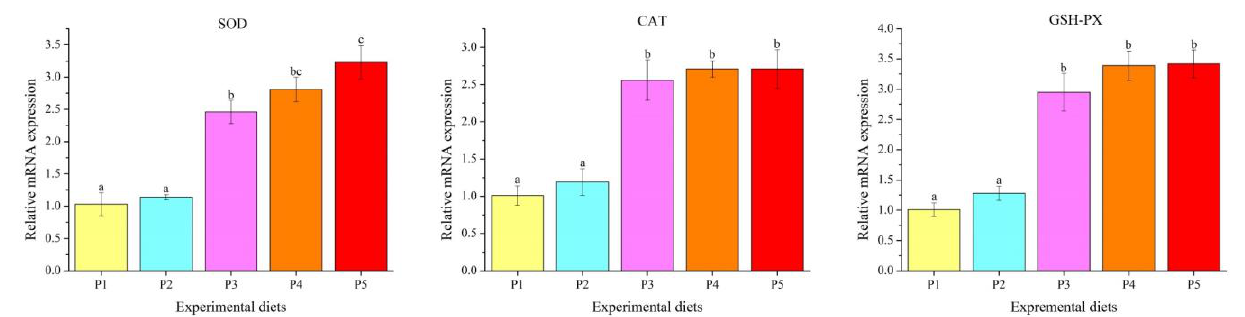
Figure 4. The mRNA levels of antioxidant-related genes in the liver of Oncorhynchus mykiss fed experimental diets. Values are presented as mean ± SE, n = 4. Means with different superscripts are significantly different ( p < 0.05). SOD: ANOVA, 0.000; linear, 0.000; quadratic, 0.000. CAT: ANOVA, 0.000; linear, 0.000; quadratic, 0.000. GSH-PX: ANOVA, 0.000; linear, 0.000; quadratic, 0.000.